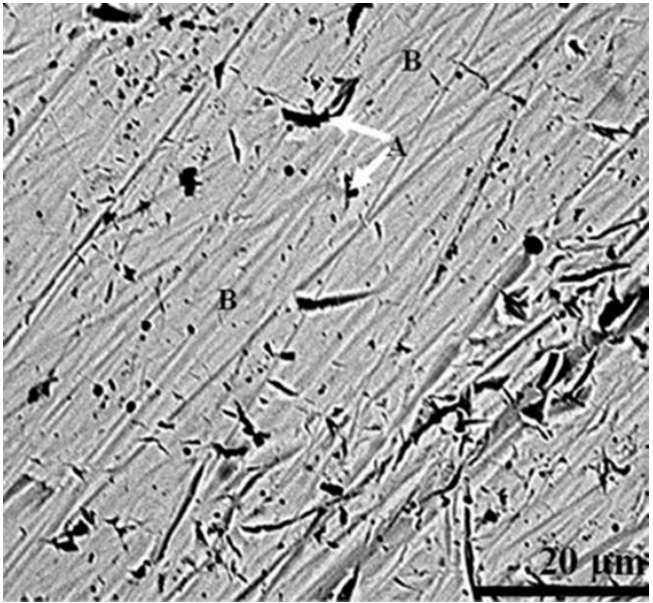
Figure 4. Scanning electron microscopy/back scattered electron image of the core region of the cross-sectioned single laser track of AISI 308LSi. A–ferrite, B–austenite. Reprinted with permission from [22], Copyright 2017 Taylor and Francis.